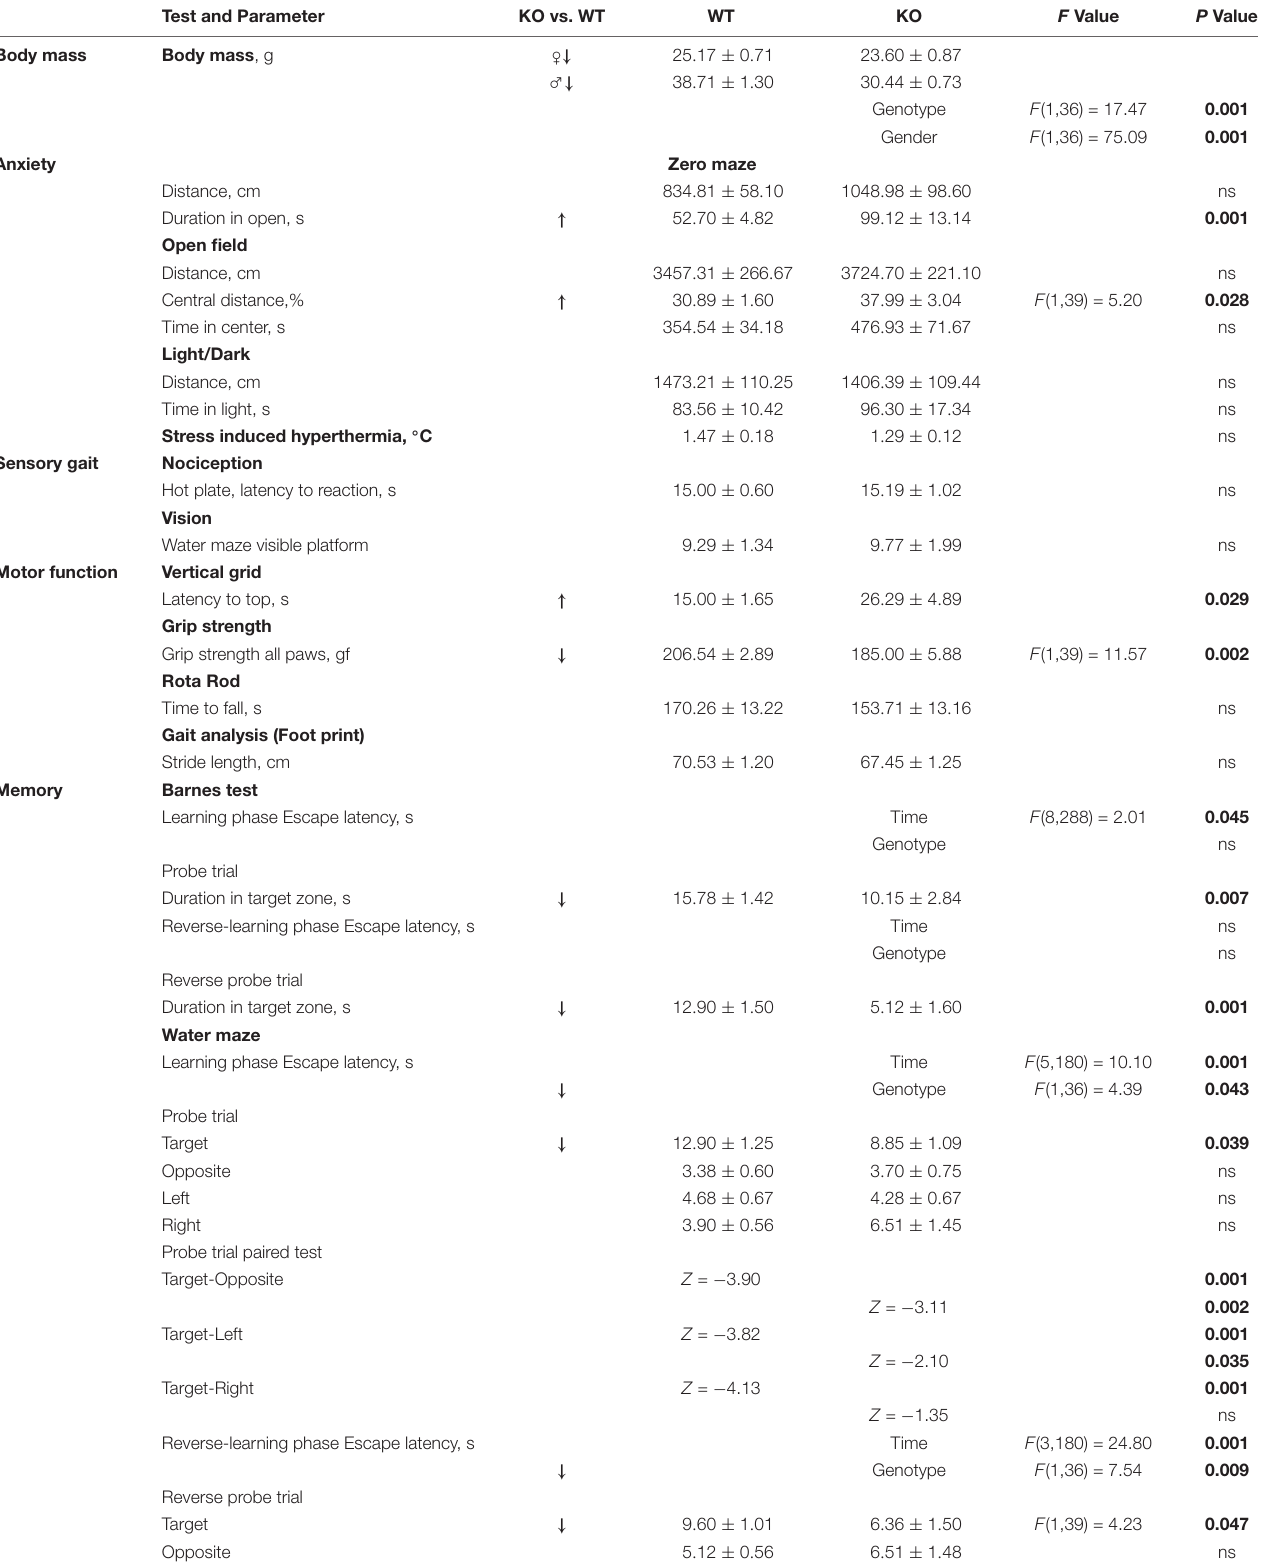
TABLE 2 | Behavioral Characterization of aged MIM KO